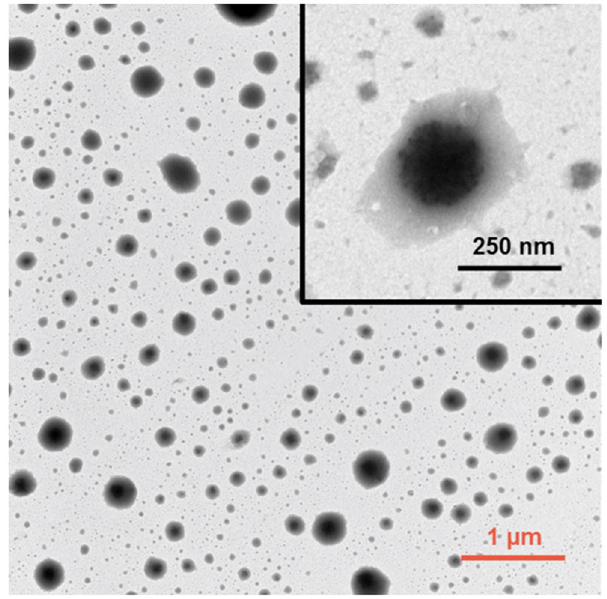
Figure 9. TEM images of pectin-coated LPN (prepared with conjugate